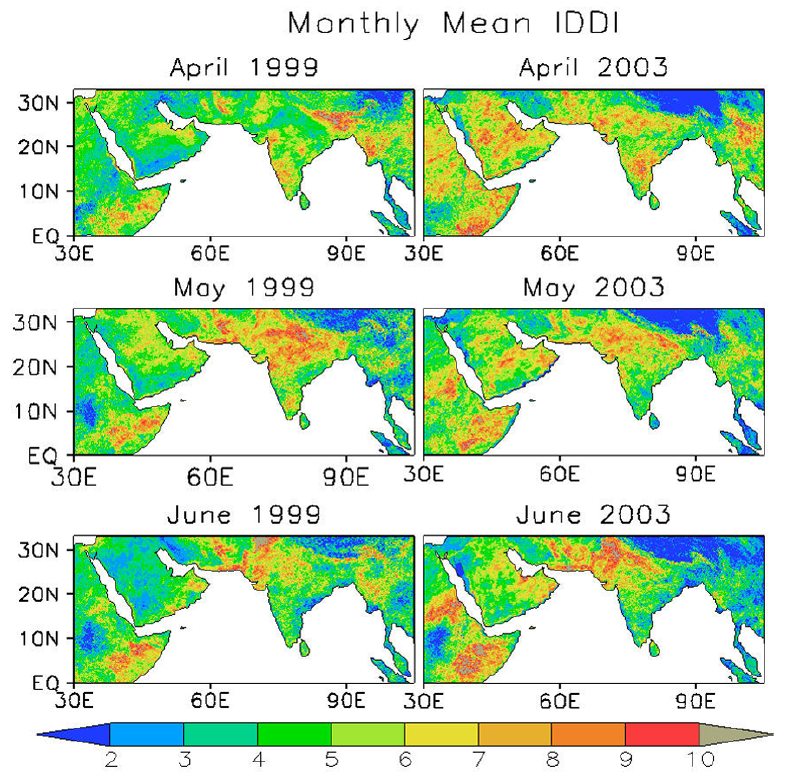
Fig. 24. Regional distribution of IDDI (K) for April, May and June (1999 and